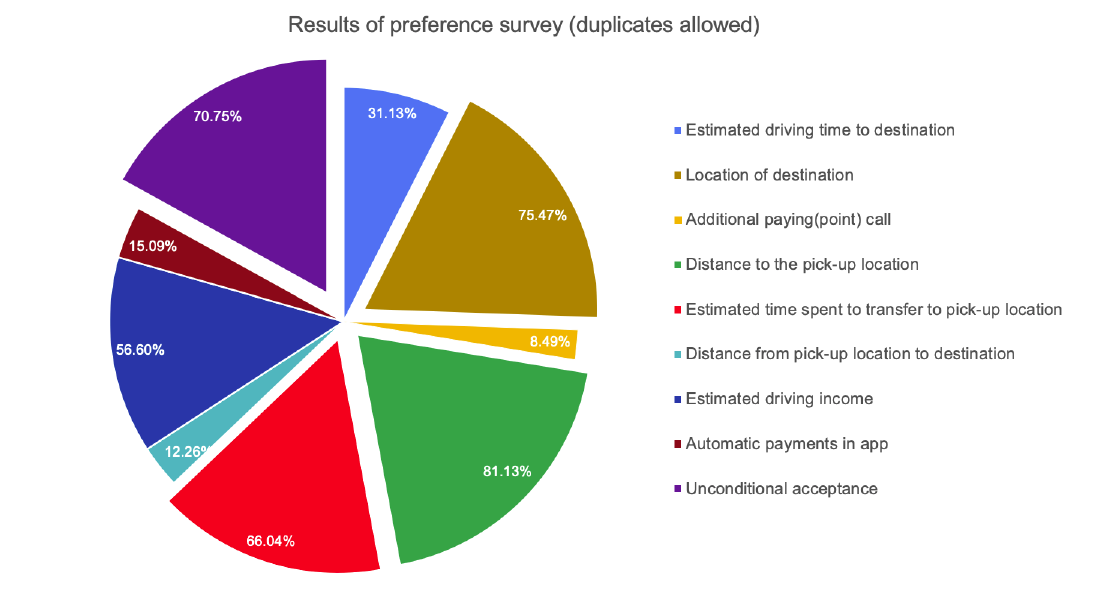
Figure 4. Results of taxi driver